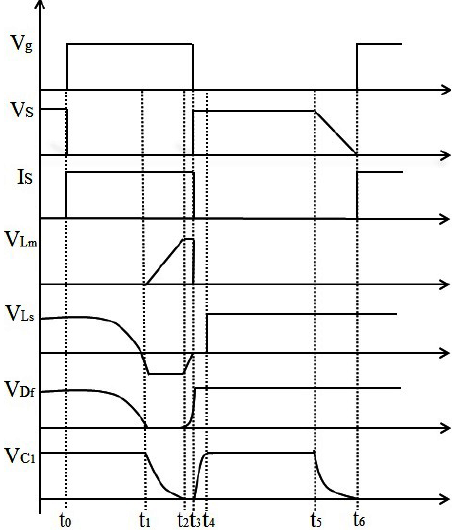
Figure 4. Typical waveforms concerning the operation stages for the converter operating in Continuous Conduction Mode (CCM).